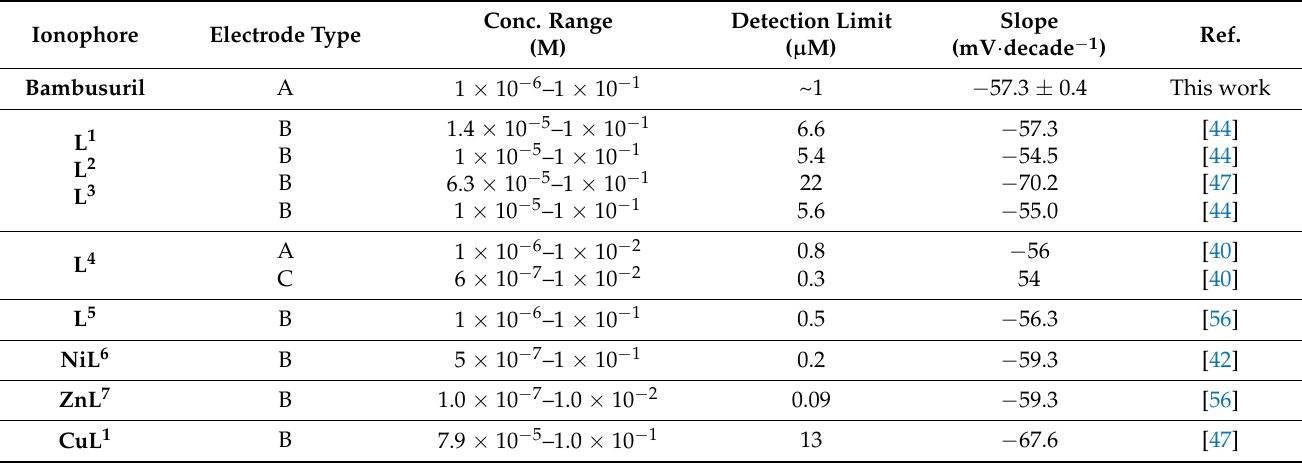
Table 4. Comparison of the perchlorate-ISE’s with ISM containing ionophore of macrocycle com- pound. The charges of ionophores are omitted for the sake of clarity. Conc. Range